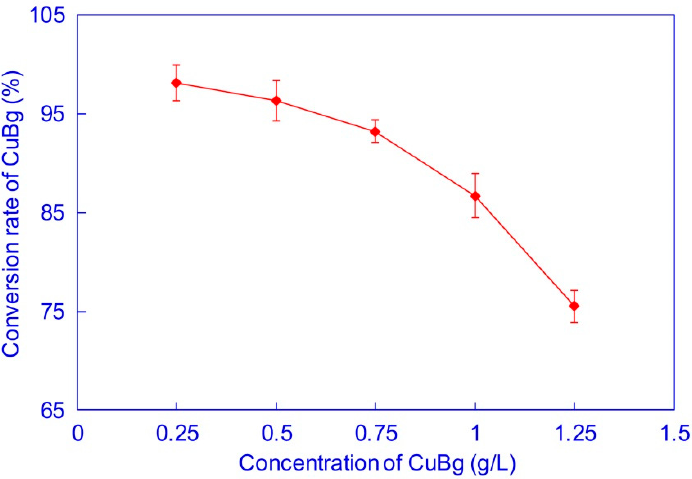
Figure 4. Conversion rate of CuBg to CuB by biotransformation using the recombinant β -glucosidase at different substrate